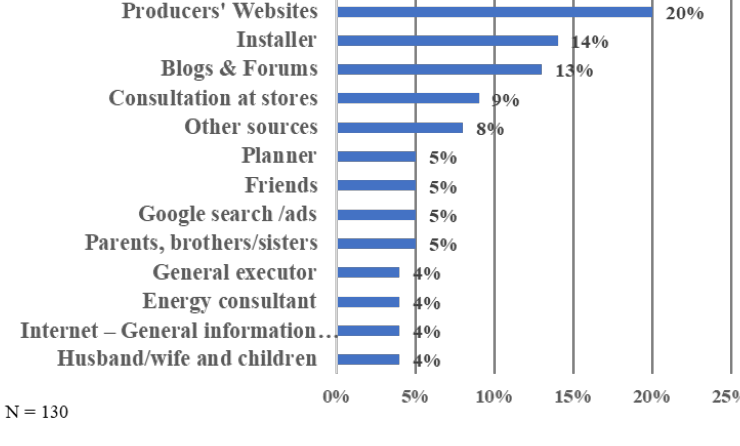
Figure 11. Post-purchase evaluation. Figure 12. Post-purchase attitude in case of satisfaction.